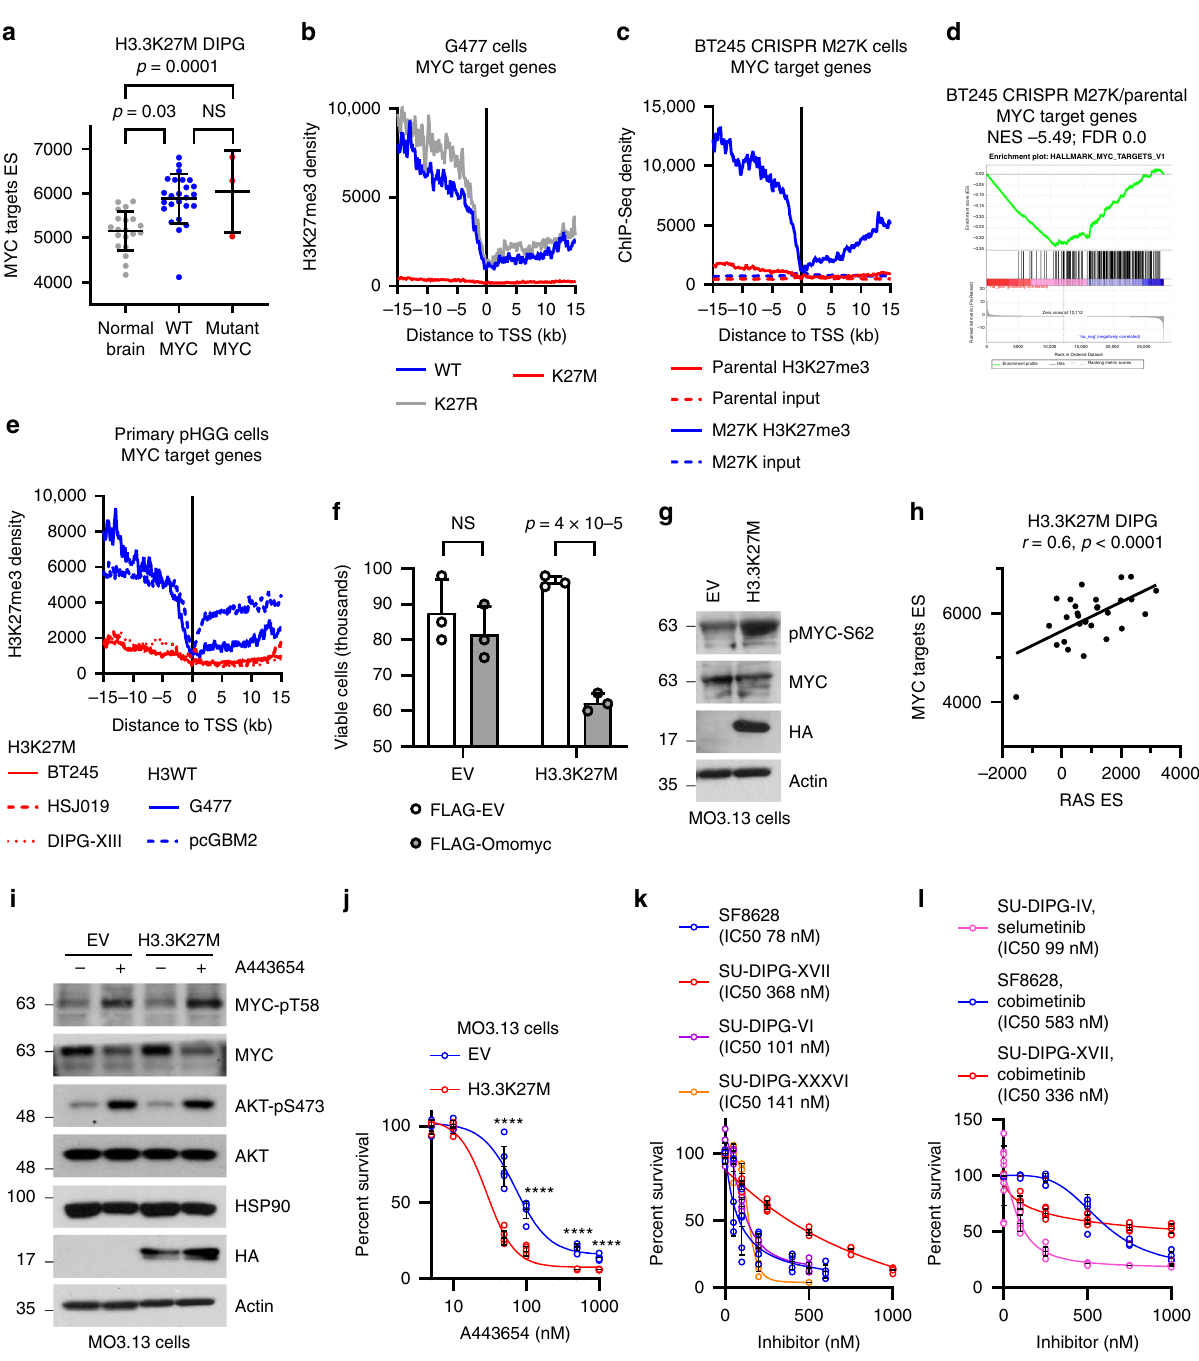
Fig. 7 Epigenetic activation of a RAS/MYC axis in H3.3K27M-driven cancers can be targeted therapeutically. a MYC target gene single sample gene set enrichment analysis (ssGSEA) enrichment score (ES) from MYC WT ( n = 25)/mutant ( n = 3) H3.3K27M DIPG and normal brain ( n = 20). b H3K27me3 ChIP-Seq density was pro fi led ± 15 kb around the transcription start site (TSS) of MYC target genes in parental, H3.3K27R or H3.3K27M G477 cells 49 . c H3K27me3 ChIP-Seq density was pro fi led ± 15 kb around the TSS of RAS target genes in parental and CRISPR-M27K BT245 pHGG cells 49 . d Gene set enrichment analysis (GSEA) of RAS target genes in CRISPR-M27K versus parental BT245 pHGG cells 49 . NES: Normalised Enrichment Score. FDR: false discovery rate. e H3K27me3 ChIP-Seq density was pro fi led ± 15 kb around the TSS of RAS target genes in H3K27M (red) and H3WT (blue) pHGG cells 49 . f Viability assay of empty vector (EV) or H3.3K27M MO3.13 cells 3 days post-transfection with FLAG-EV or FLAG-Omomyc plasmids. Bars show mean ± standard deviation ( n = 3). g Western blot of EV and H3.3K27M-expressing MO3.13 cells (results are representative of 2 independent experiments). h Scatter plot of ssGSEA ES of RAS and MYC target genes in human H3.3K27M DIPG ( n = 29). r : Pearson correlation. i Western blot of EV and H3.3K27M MO3.13 cells treated or not with A443654 (50 nM) for 3 days (results are representative of 2 independent experiments). j Viability assay of EV and H3.3K27M MO3.13 cells treated or not with A443654 for 3 days. Bars show mean ± standard deviation ( n = 4). k Viability assays of DIPG cells treated or not with the indicated MEK inhibitor for 3 days. Bars show mean ± standard deviation ( n ≥ 5). l Viability assays of DIPG cells treated or not with A443654 inhibitor for 3 days. Bars show mean ± standard deviation ( n ≥ 5). Source data are provided as a Source Data fi le. Statistical tests: ANOVA ( a , f ), t ( h , j ). **** p < 0.0001, NS: not signi fi